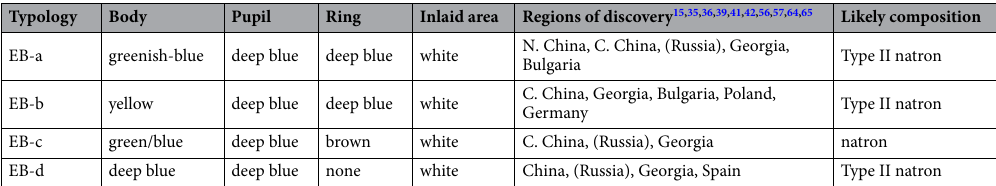
Table 2. Four types of mid-1st millennium BCE stratified eye beads across Eurasia. Parentheses indicate probable cases. Likely composition for a type is inferred from samples of that type with trace element information reported. Sites of discovery: EB-a: Dren-Delyan (Bulgaria) 36 , Pichvnari (Georgia) 39 , the tomb of Zhaoqing (north China) 64 , Zenghouyi (central China) 57 , and Shanghai Glass Museum (unspecified context) 64 ; EB-b: Altdorf (Germany) 41 , Owidz (Poland) 42 , Dren-Delyan 36 , Pichvnari 39 , National Museum of Georgia (unspecified context, personal visit), Zenghouyi 57 , and Shanghai Glass Museum 64 ; EB-c: Xujialing (central China) 56 , Zenghouyi 57 , Hougudui (central China) 15 , and Pichvnari 39 ; EB-d: from Son Mas (Spain) as fragments 35 , and from Svaneti Museum in Georgia (unspecified context, personal visit), National Museum of Georgia, and Shanghai Glass Museum 64 . Additionally, eye beads that might be of EB-a, EB-c, and EB-d types were reported from Filippovka I burials in Southern Urals that were considered to date to 4–3 C. BCE (images inconclusive 65,66 ).